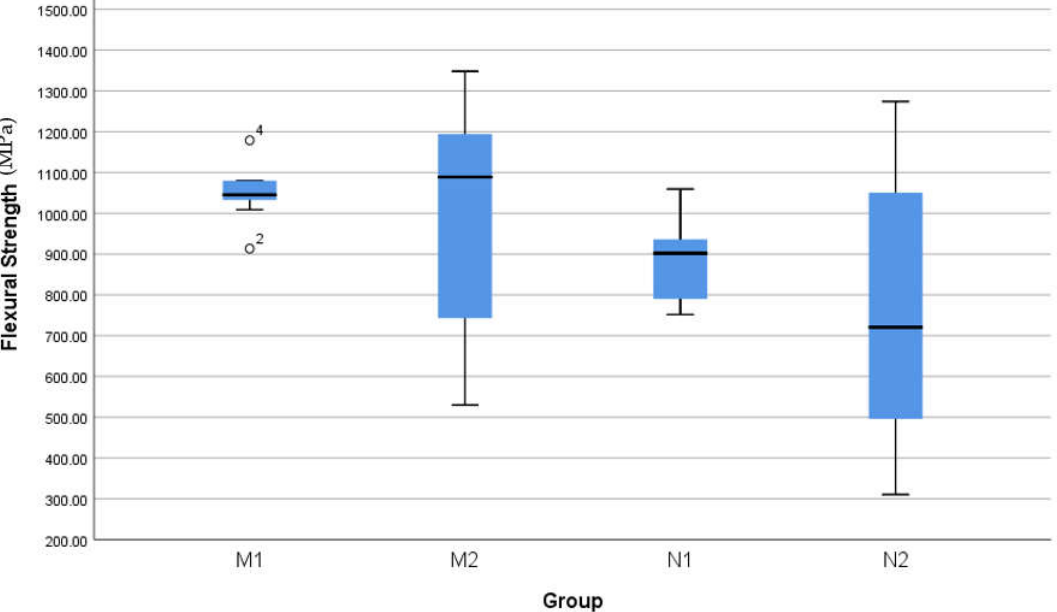
Figure 5. Box and whisker plots of the flexural strength, comparing the range of values spread between groups. Note the outliers in M1, but still considered high values.